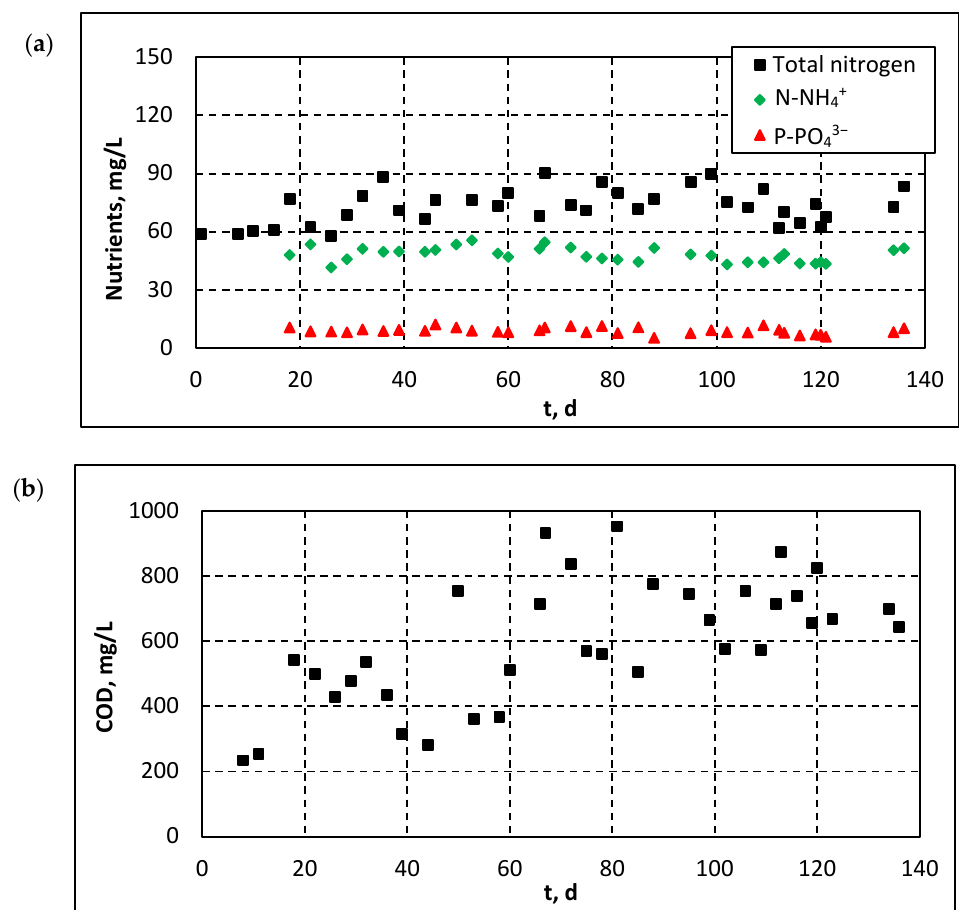
Figure 6. Evolution of concentrations of: ( a ) nutrients and ( b ) COD in the influent wastewater.